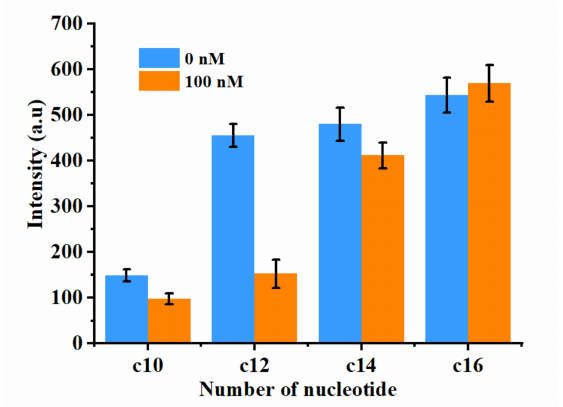
Figure 1. Effects of n-cDNA on the fluorescence intensity of the A35-apt coupled with FAM labeling in the absence (0 nM) or presence (100 nM) of AFB 1